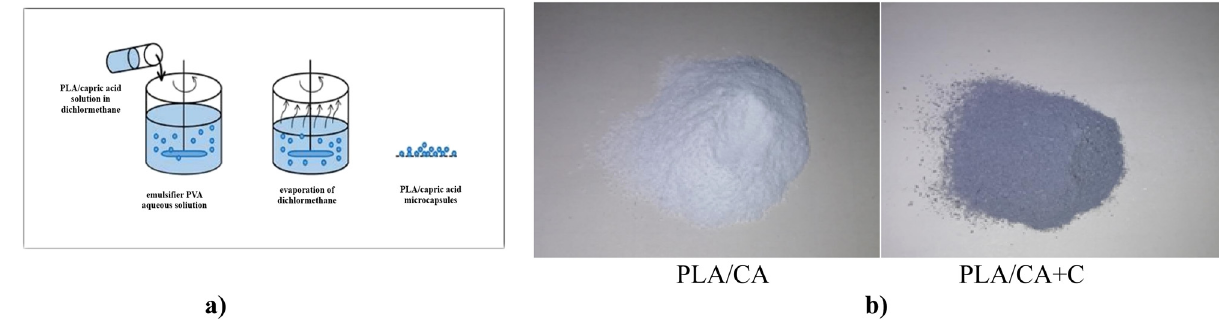
Figure 2: ( a ) Preparation of microcapsules and ( b ) image of the prepared